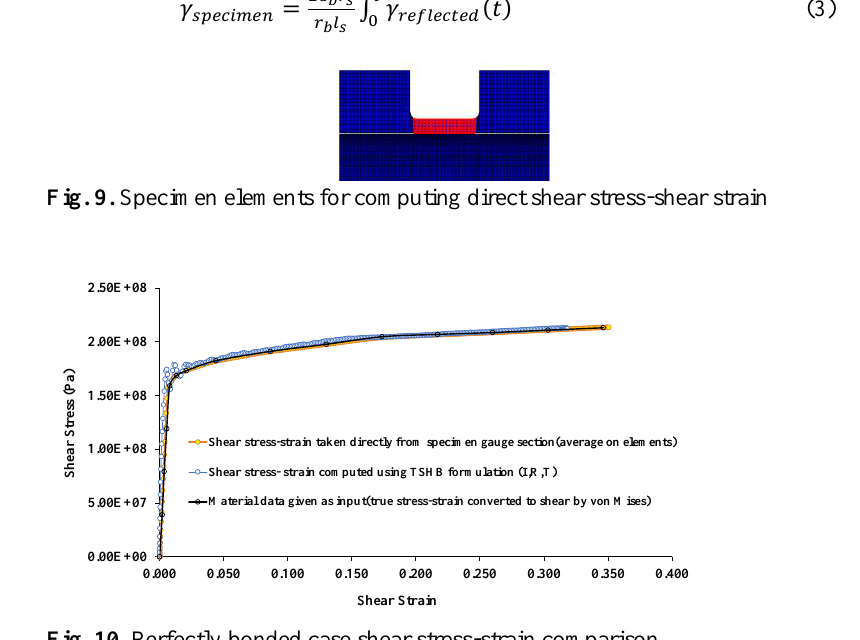
Shear stress-strain taken directly from specimen gauge section(average on elements) Shear stress- strain computed using TSHB formulation